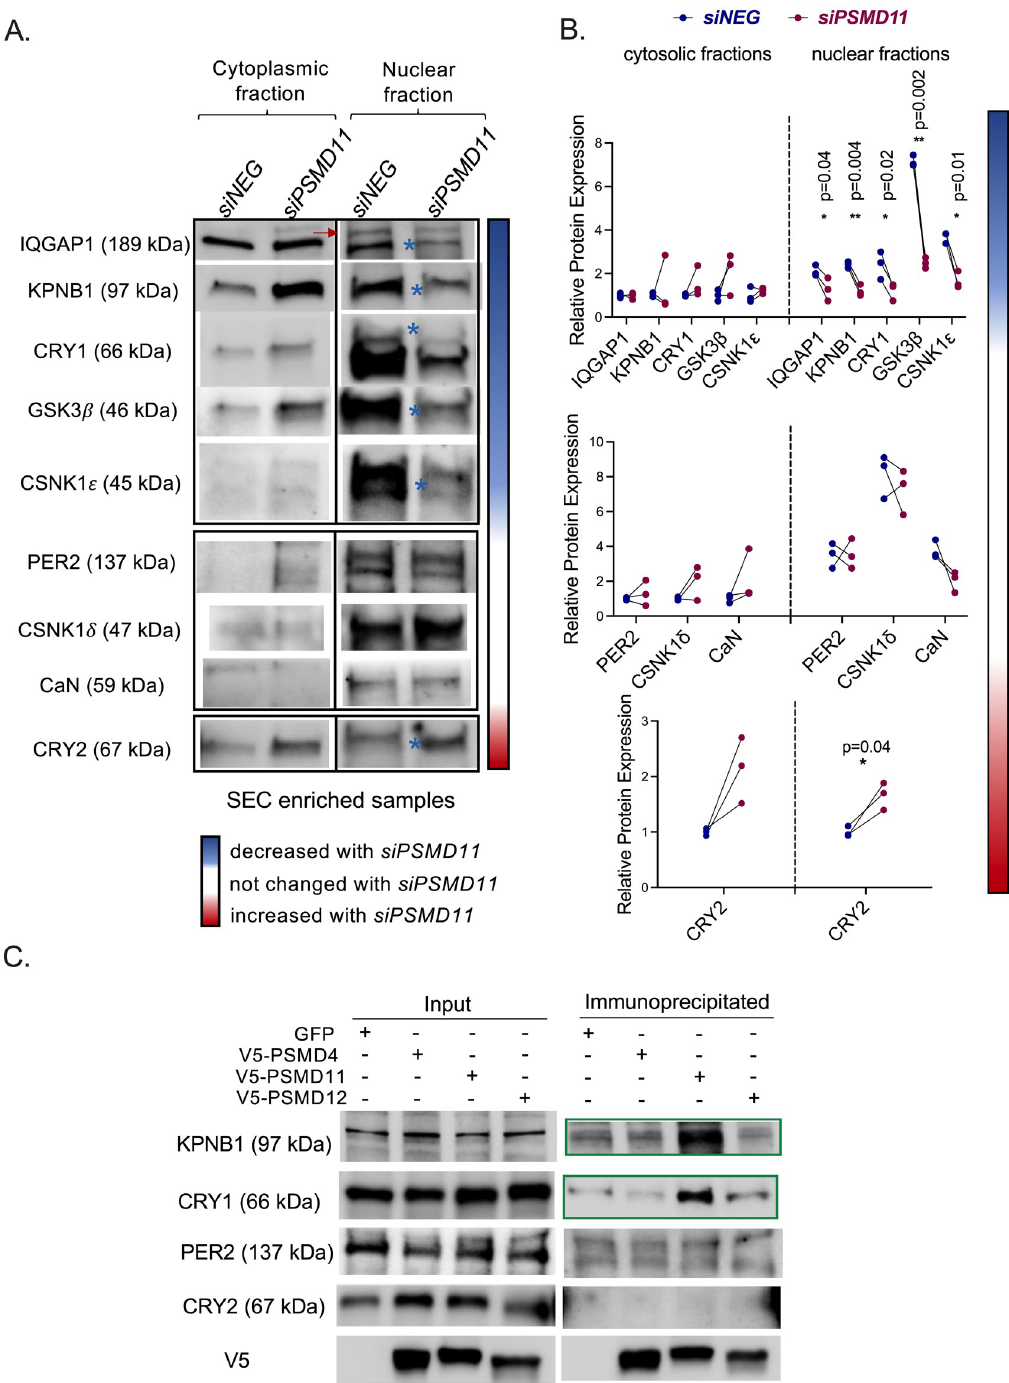
Fig 4. PSMD11 regulates circadian clock by regulating nuclear transport of the NRON complex. (A) Indicated proteins are detected in control ( siNEG ) and siPSMD11 samples in SEC enriched cytoplasmic and nuclear fractions of unsynchronized U2 OS cells. Cytoplasmic and nuclear fractions for each protein are run on the same gel, then cut and pasted together for representation. Arrow indicates a non-specific band. Significantly affected blots by siPSMD11 are marked with blue asterisks on Western blot images. (B) Graphs represent Western blot quantifications of three independent experiments shown in (A). Significancy is analyzed with paired t test. P-values of the significant analyses are displayed on the graph. (C) Pulldown assay using whole cell lysates of U2 OS cells overexpressing PSMD-V5 plasmids or GFP. Pull down experiment repeated two times.